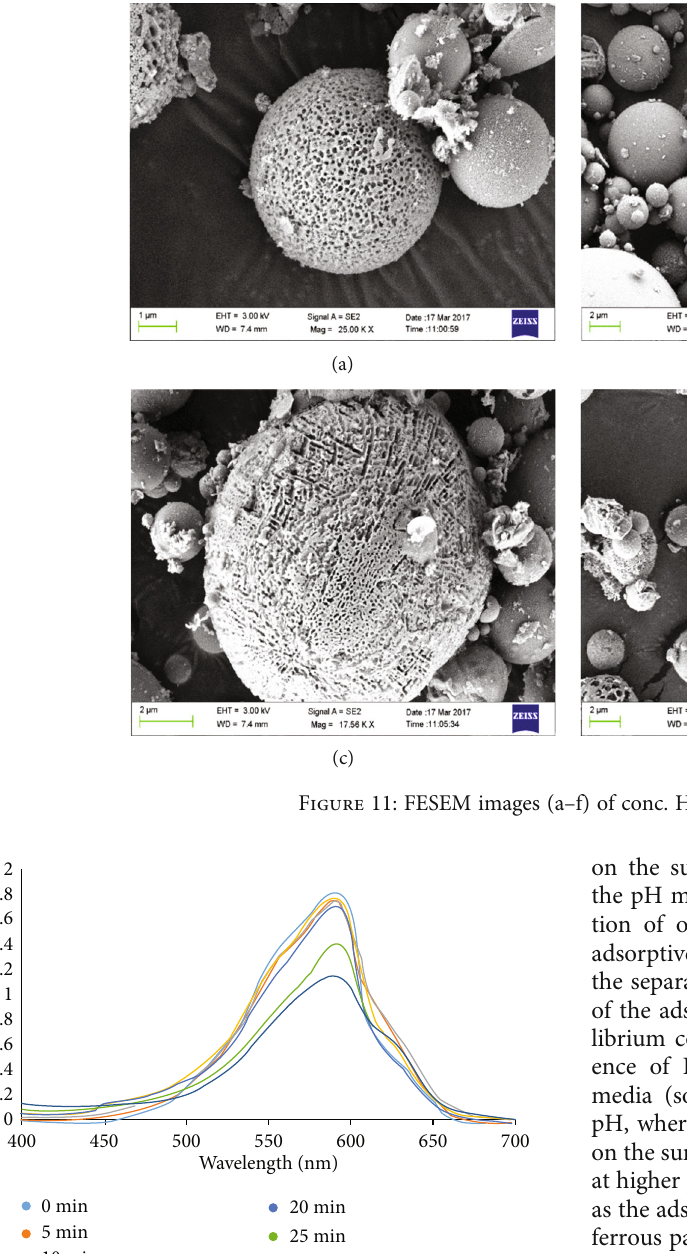
Figure 12: Absorption spectrum representing time-dependent removal of Azure A dye by surface-modi fi ed